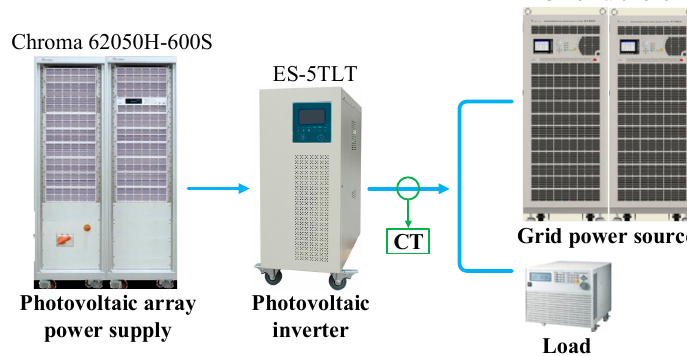
Figure 4. An experimental platform of a 5 kW VSC-based renewable energy.